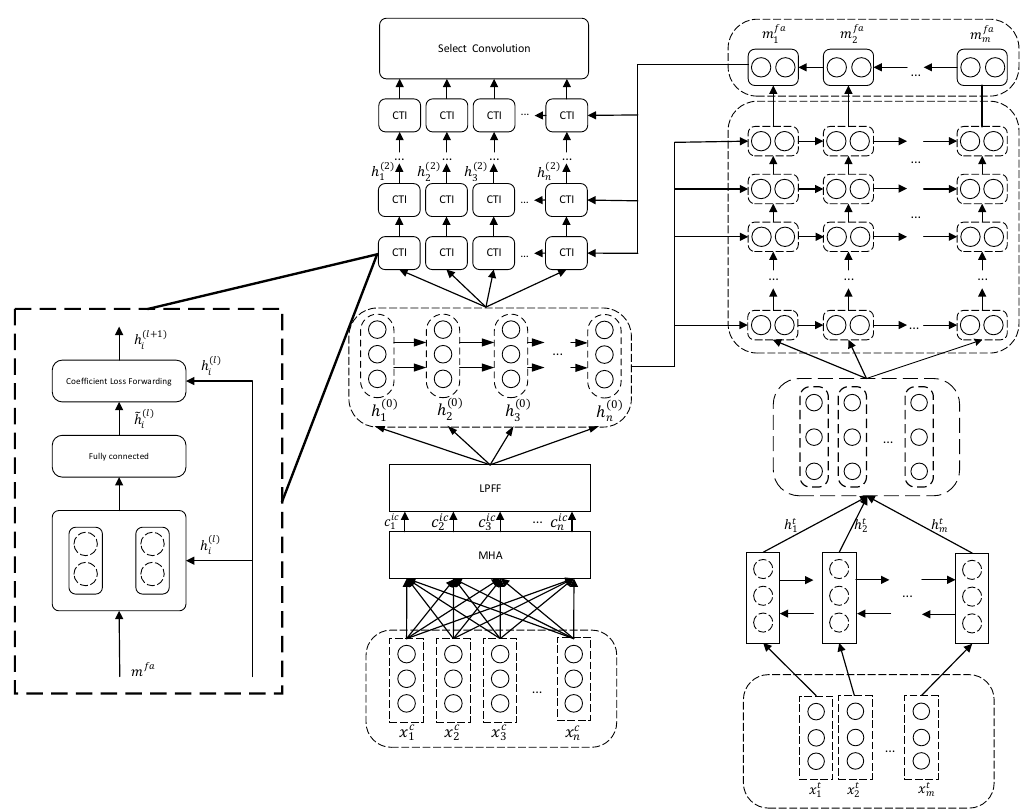
Figure 1. The overall architecture of the Multiple Interactive Attention Network (MIN) design.